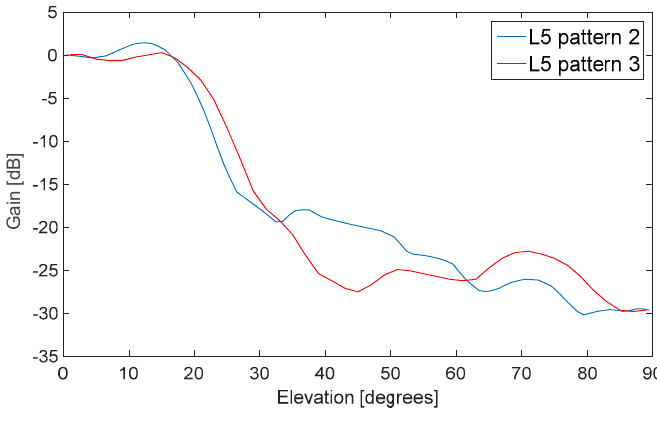
Figure 5. GPS L5 antenna gain pattern.